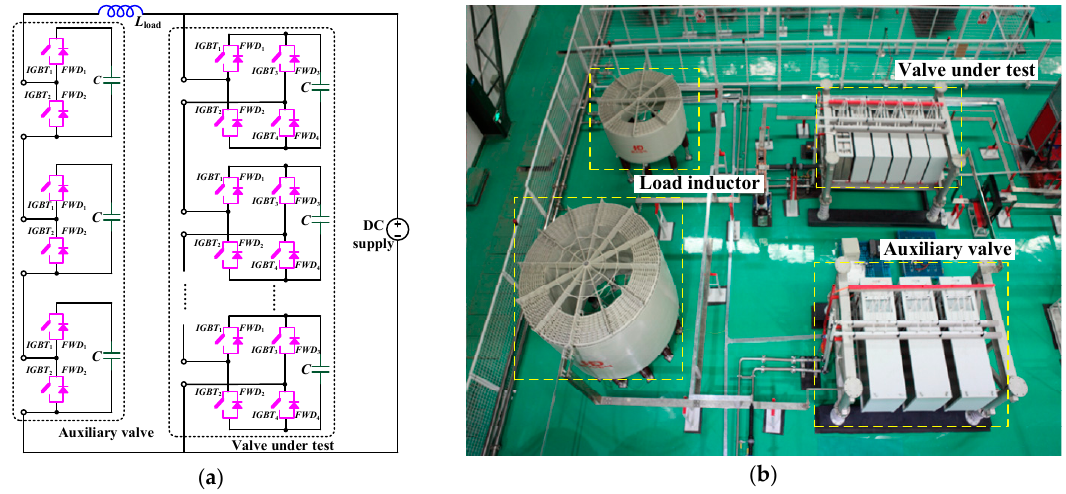
Figure 12. Type test setup of MMC valves: ( a ) Schematic diagram of test setup; ( b ) Top view of test